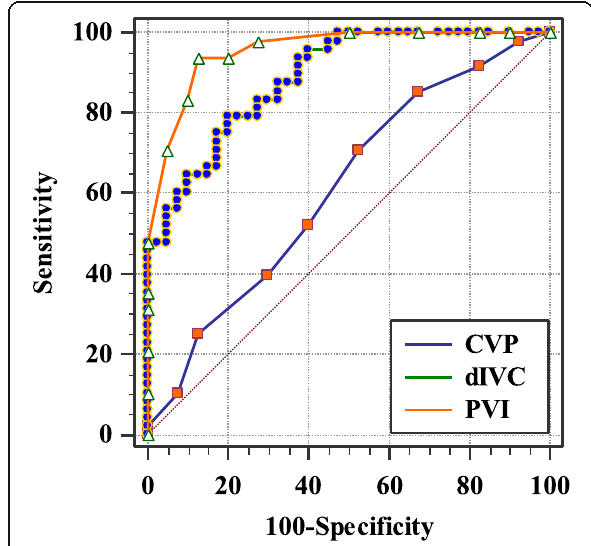
Fig. 1 The receiver-operating characteristic curves comparing the ability of CVP, dIVC, and PVI to predict fluid responsiveness. CVP, central venous pressure; dIVC, caval index; PVI, pleth variability